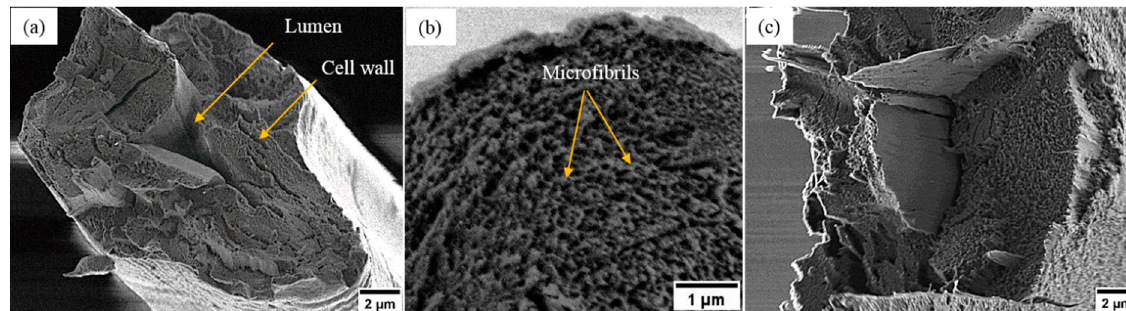
Figure 3. LV-SEM images of the cross-section of ramie fiber ( a ) overview of the cryo-fractured single ramie fiber, ( b ) the cryo-fractured cell wall, ( c ) the tensile fractured cell wall, more SEM images are shown in the supplementary materials (Figure S5).